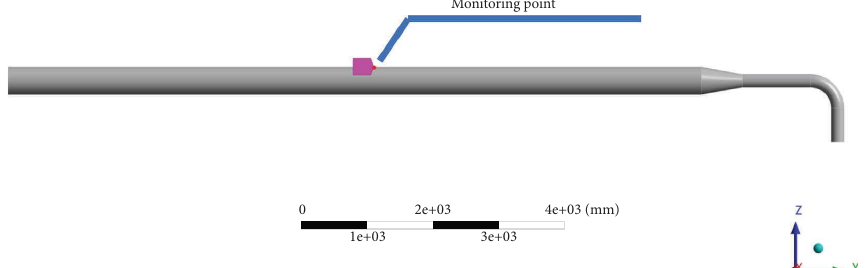
Figure 5: Diagram of the location of the monitoring point.